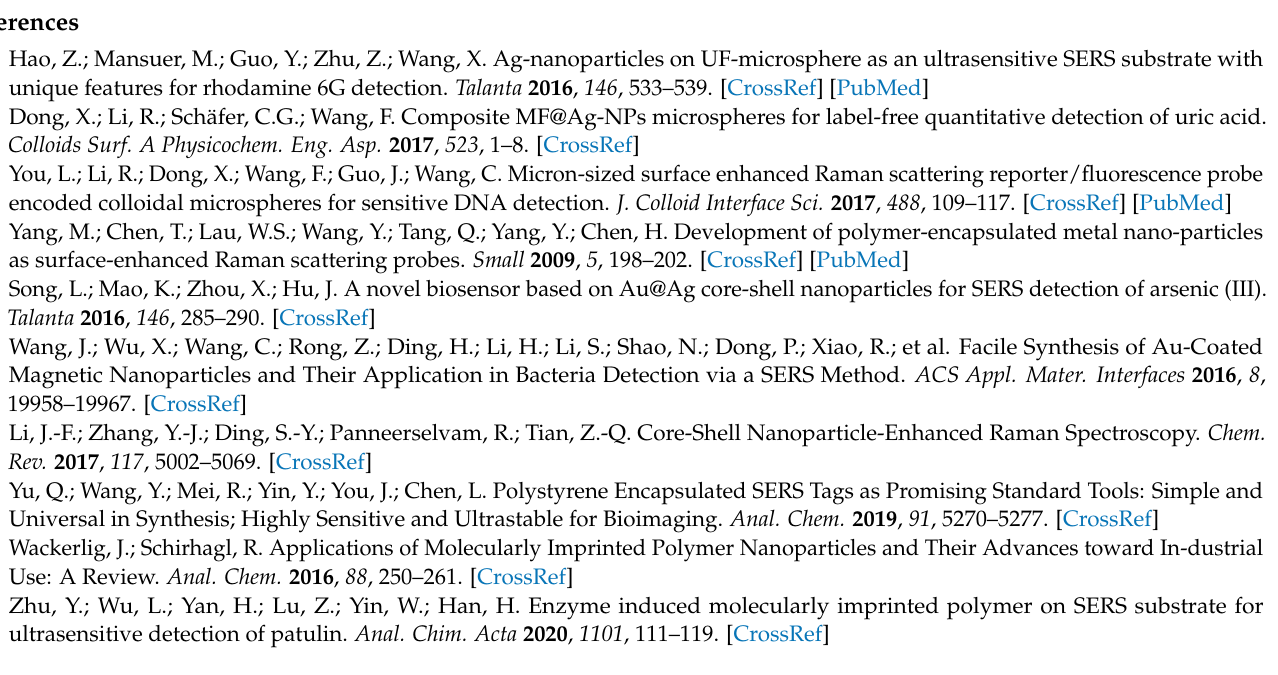
crospheres, Figure S2: Two extreme structures in MF n polymers, Figure S3: Two extreme structures in linear MF n polymers, Figure S4: Two ideal units in linear MF n polymer structure with the F/M molar ratio n = 1.5, Figure S5: Influence of polymerization degree m on the F/M molar ratio n in an ideal linear polymer structure, Figure S6: Influence of polymerization degree m on the F/M molar ratio n in the planar or three-dimensional structures, Figure S7: Linear structure of an MF n polymer molecule (Structure L), Figure S8: Planar structure of an MF n nonamer (Structure P 9 ), Figure S9: Three-dimensional structure of an MF n seventy-two polymer (Structure T 72 ), Figure S10: Terminal overreaction at the end of a linear MF n molecule (Equation LO), Figure S11: Terminal overreaction at the end of a planar MF n nonamer (Equation P 9 ), Figure S12: Terminal overreaction at the end of a three-dimensional MF n seventy-two polymers (Equation T 72 ), Figure S13: Silver concentration as a function of absorbance from spectrophotometry, Figure S14: SERRS performance of AgNPs treated with the liquor from MF 6 acid-treatment reaction, Figure S15: SERRS spectra of a set of analytes col- lected on AgNP/MF 6 substrate, Figure S16: SERRS spectrum as a function of the tetramethylthiuram disulfide concentration on the optimized AgNP/MF 6 , Figure S17: SERRS spectrum as a function of the malachite green concentration on the optimized AgNP/MF 6 , Figure S18: SERRS spectrum as a function of the p-hydroxythiophenol concentration on the optimized AgNP/MF 6 , Figure S19: SERRS spectrum as a function of the basic violet 14 concentration on the optimized AgNP/MF 6 , Table S1: Calculation of silver content in the AgNP/MF 3